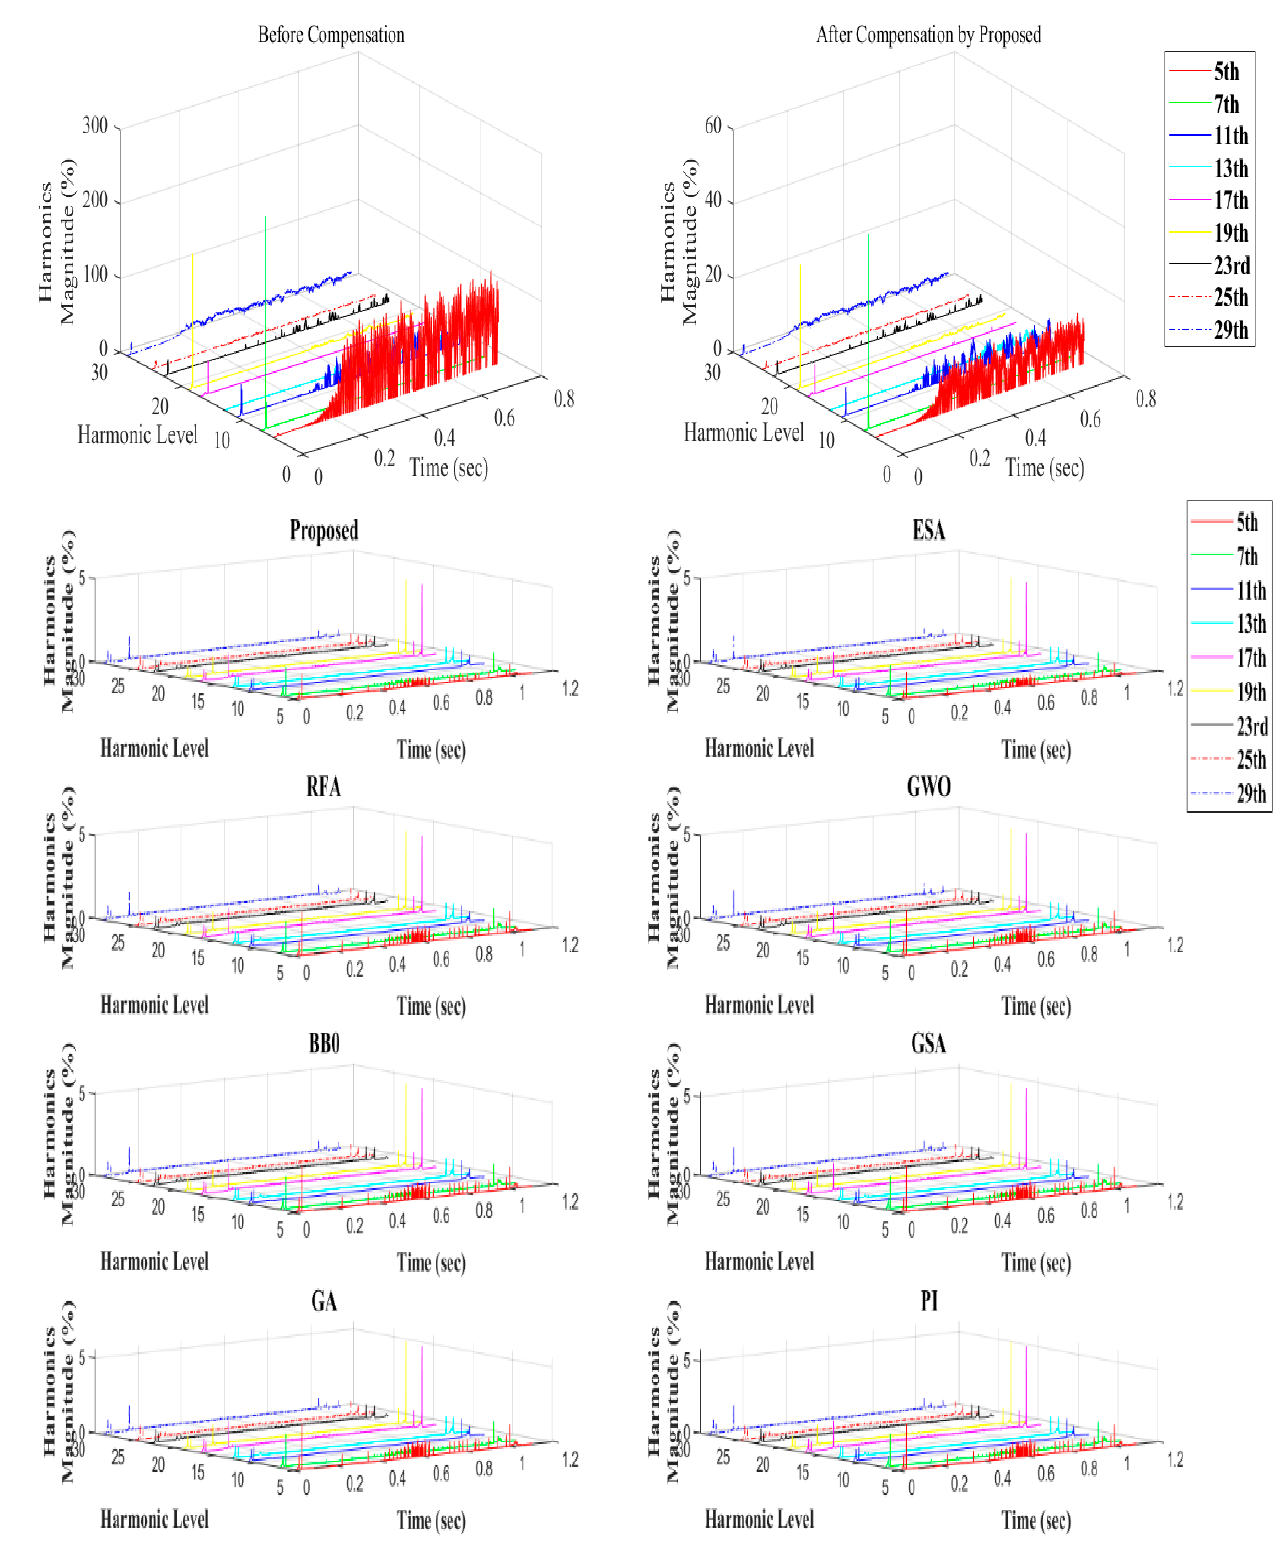
Figure 16. Analysis of THD comparison.